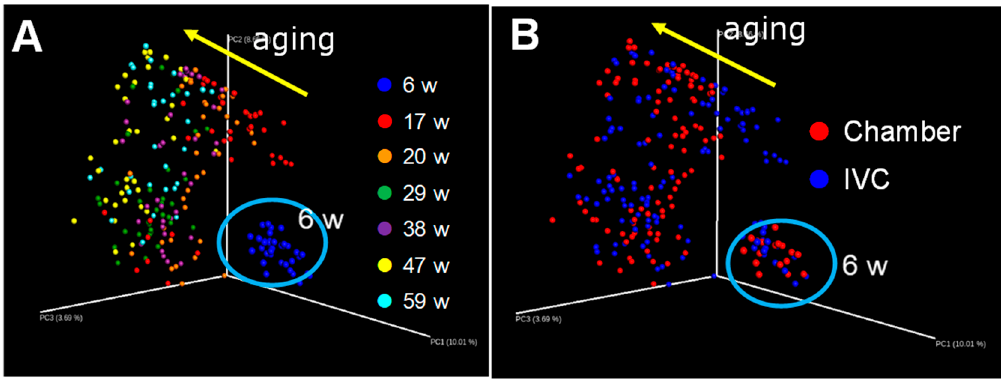
Figure 11. Changes in the intestinal microbiome with aging in the chamber and IVC groups: UniFrac analyses (unweighted); ( A ) ages; ( B ) groups.